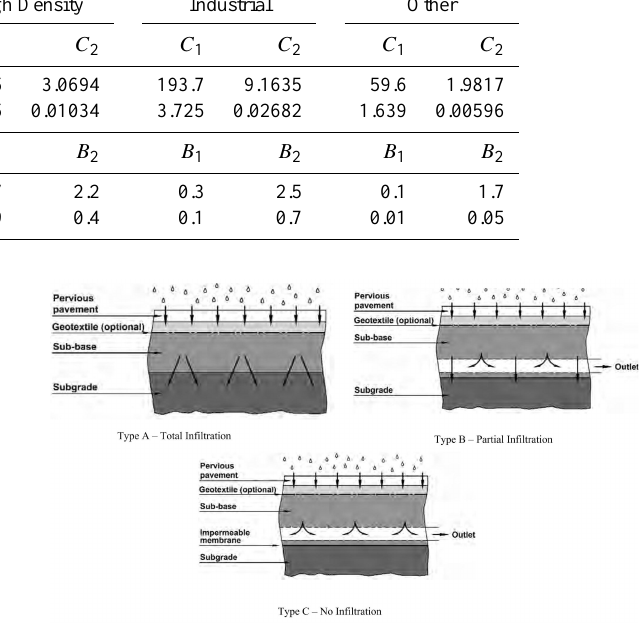
Fig. 2. Porous pavement system (Woods-Ballard et al.,